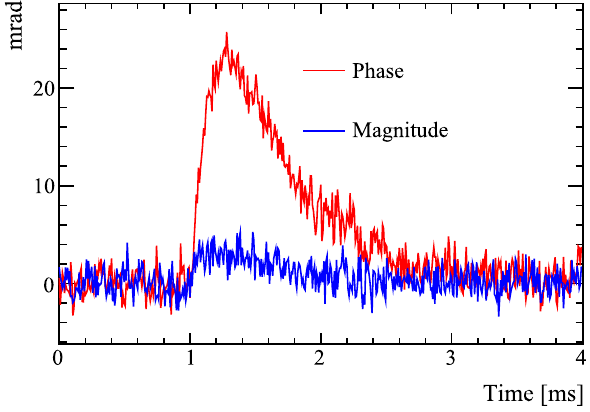
Fig. 4 Triggered1.3keVsignalinthephase(red)andamplitude(blue)